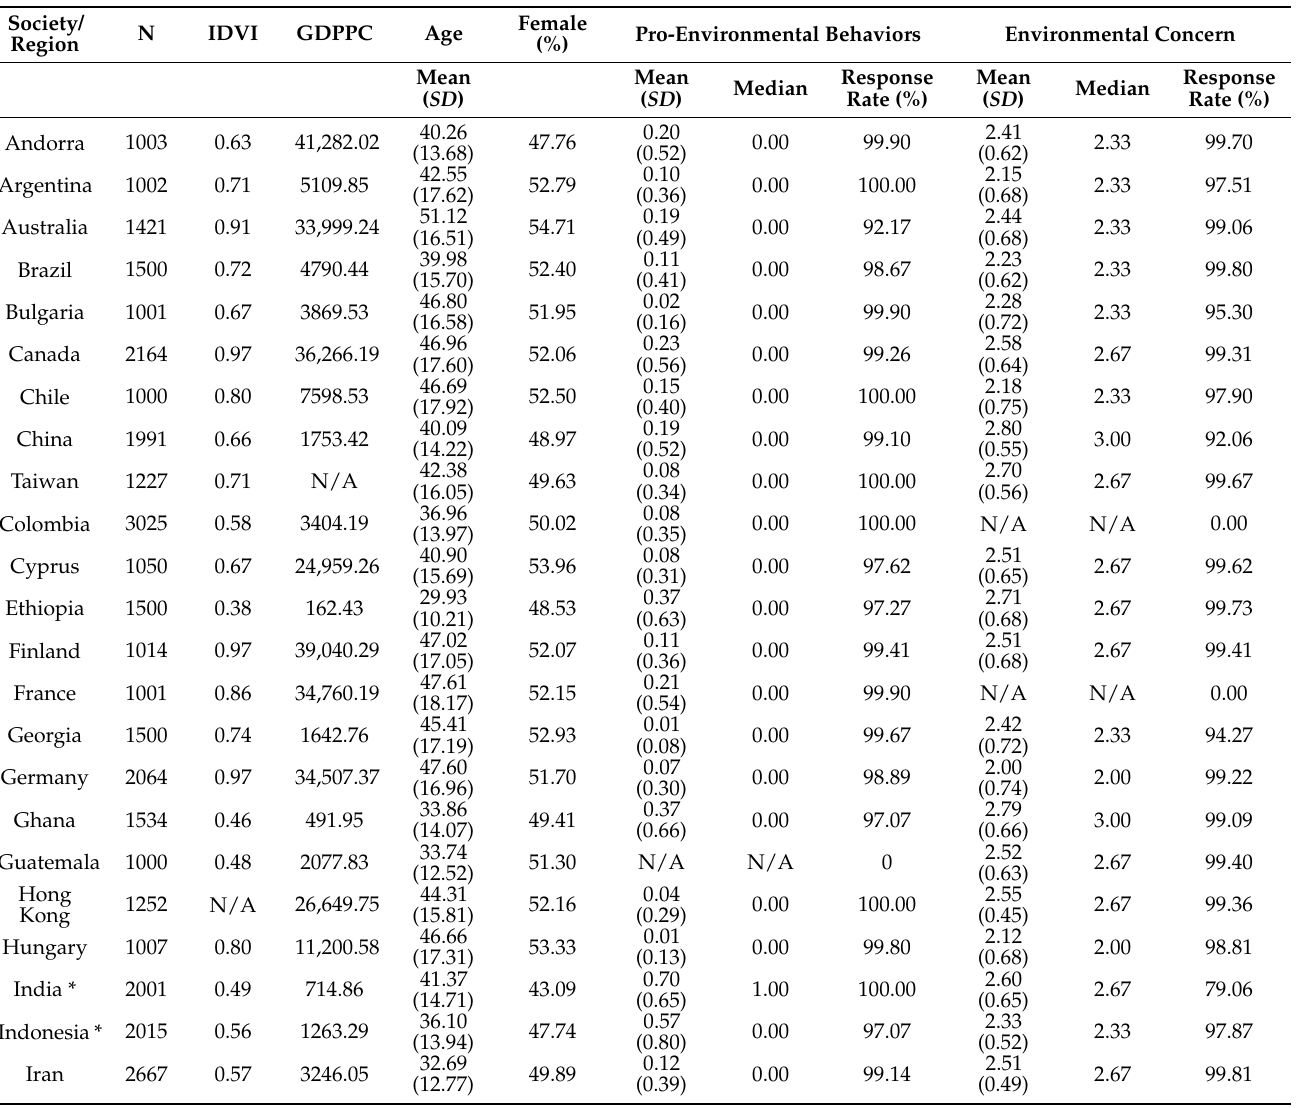
Table 1. Descriptive information of the 56 societies in Study